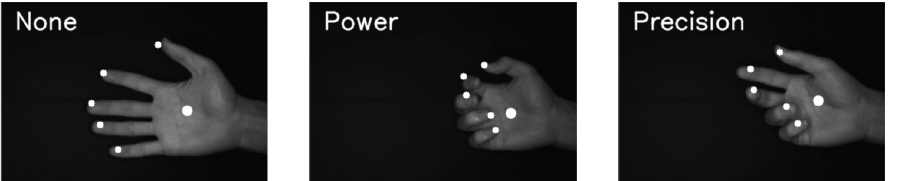
Figure 12. Difference among non-grasp, power grasp, and precision grasp and fingertip and palm positions (white circles).